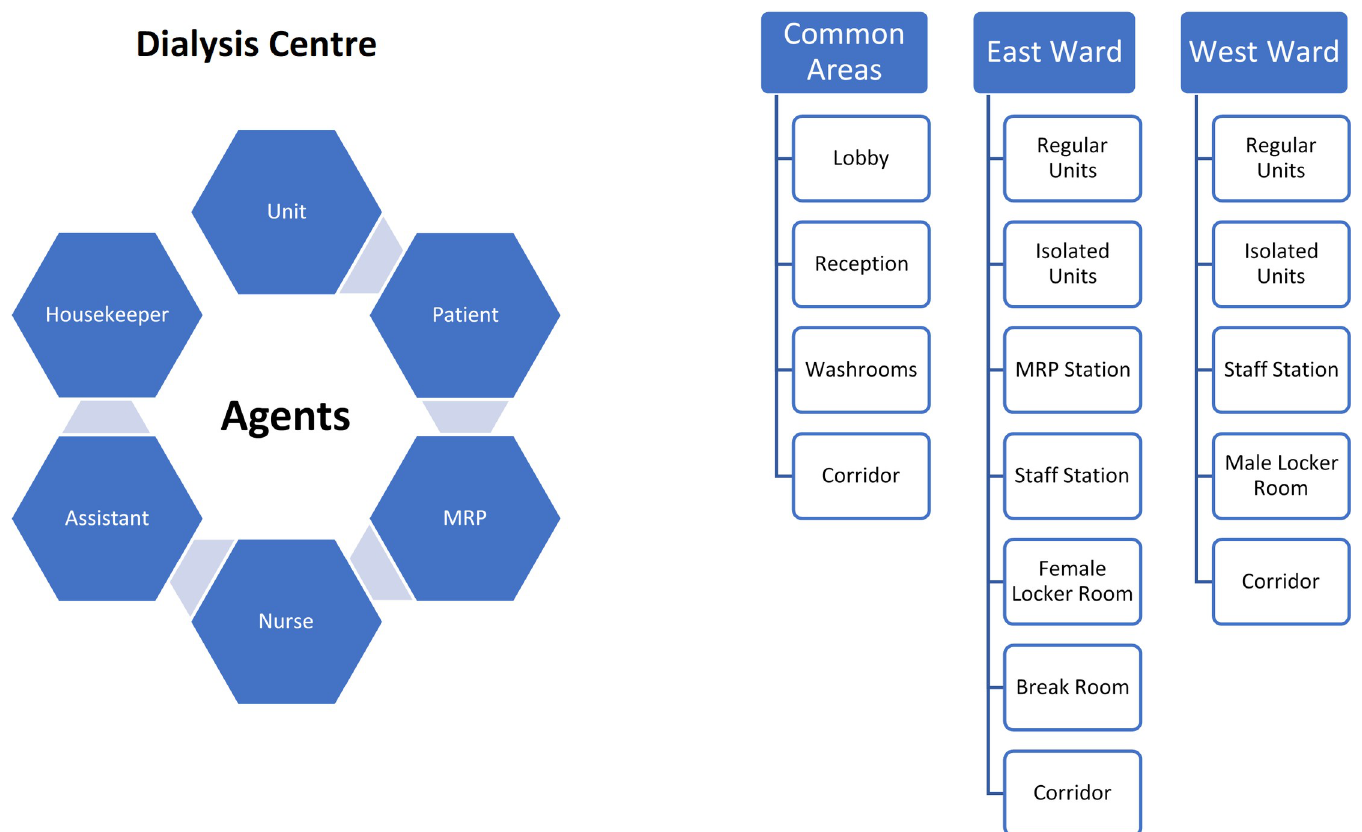
Fig 2. General structure of the agent-based simulation model (Left: Agents, Right: Environment Detail).